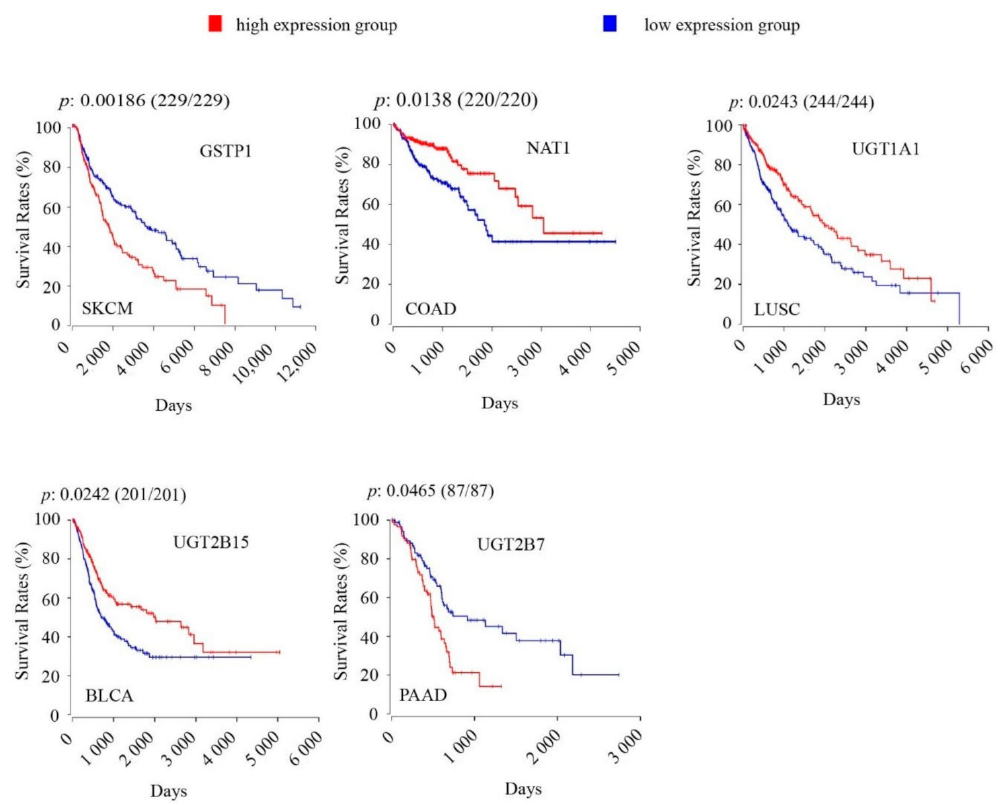
Figure 3. Kaplan-Meier survival analysis and Logrank test show significant associations of intratumoral expression levels of core ADME genes coding for phase II drug-metabolizing enzymes with overall survival rates in TCGA cancers. For Kaplan-Meier survival analysis, the patients were separated into high-expression group (upper 50 percentile, red curve) and low-expression group (lower 50 percentile, blue curve) by gene expression levels in each TCGA cancer type as indicated. The number of patients in each group was given in bracket following the p -value. A Bonferroni-corrected cuto ff logrank p -value of < 0.05 indicates statistical